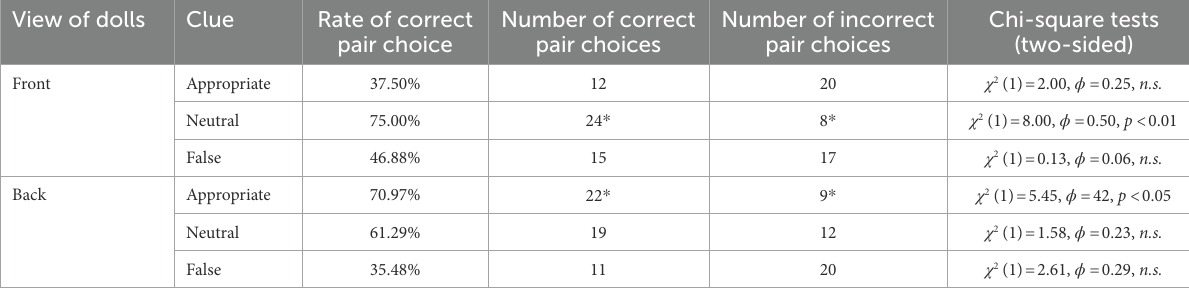
TABLE 2 The numbers and rates of choosing the matching pairs. View of dolls Clue Rate of correct